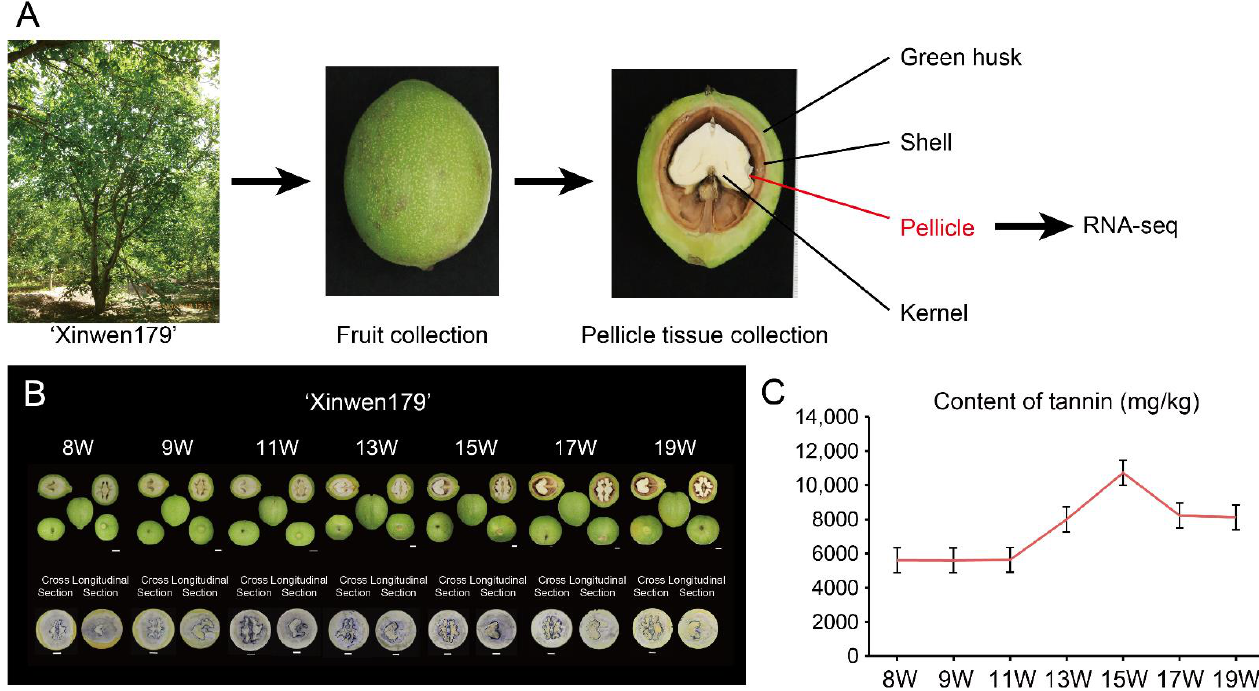
Figure 1. Phenotype and dynamic content of tannin in walnut variety ‘Xinwen179’. ( A ) Overview of the experimental design. The fruits of early-flowering walnut cultivar ‘Xingwen179’ were harvested at seven stages (8 W, 9 W, 11 W, 13 W, 15 W, 17 W, and 19 W). RNA-seq was performed with three biological repeats; ( B ) he phenotype of walnut variety ‘Xinwen179’ from 8 W to 19 W, showing the appearance of fruit (upper panel) in cross- and longitudinal sections (bar = 1 cm); ( C ) Tannin content with three biological replicates